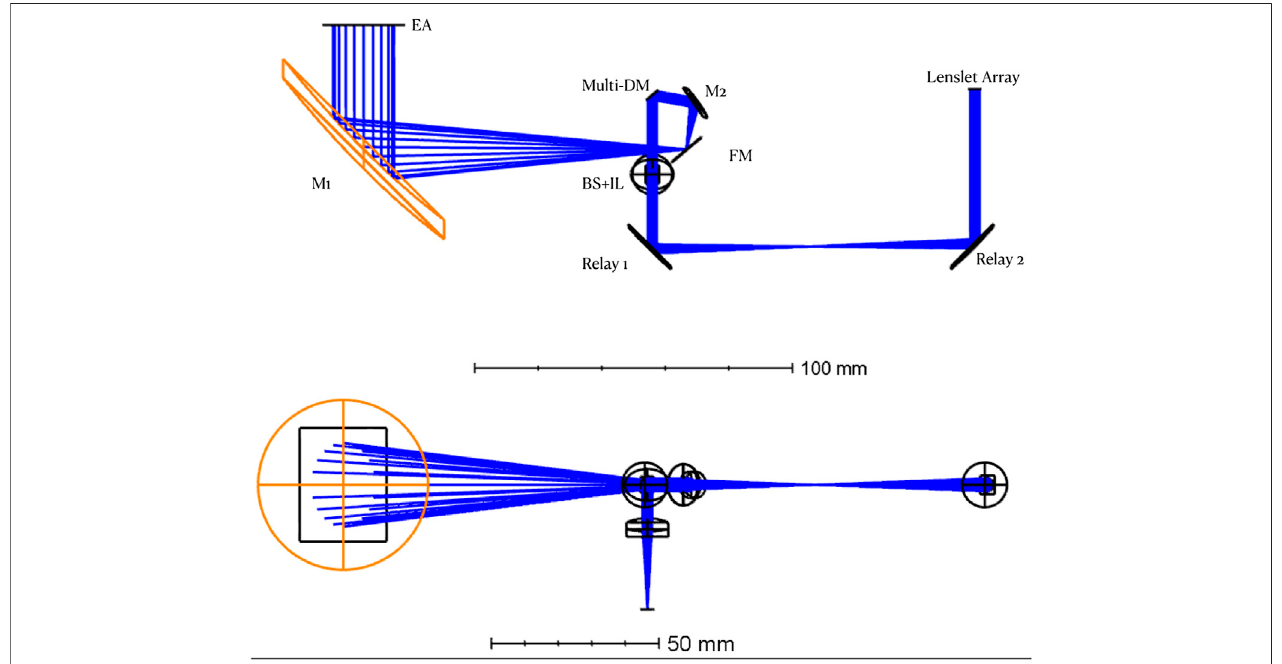
FIGURE2| TopandsideraytracesoftheDeMiopticallayout.EA(entranceaperture)isde fi nedatthebaf fl eoutput.OAPsM1andM2relayanimageofthatpupilto the surface of the Multi DM, the output collimated beam from which is split by a beamsplitter (BS) between an imaging lens (IL) and second pair of OAPs which relay an image of the DM surface to the lenset array which acts as a SHWFS. See Table 1 for component level specs and Table 2 for system